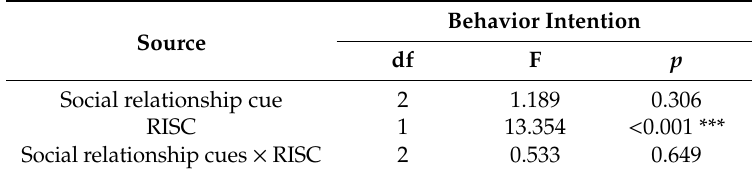
Table 5. ANOVA results of social relationship cues and relational-interdependent self-construal (RISC) on behavior intention.